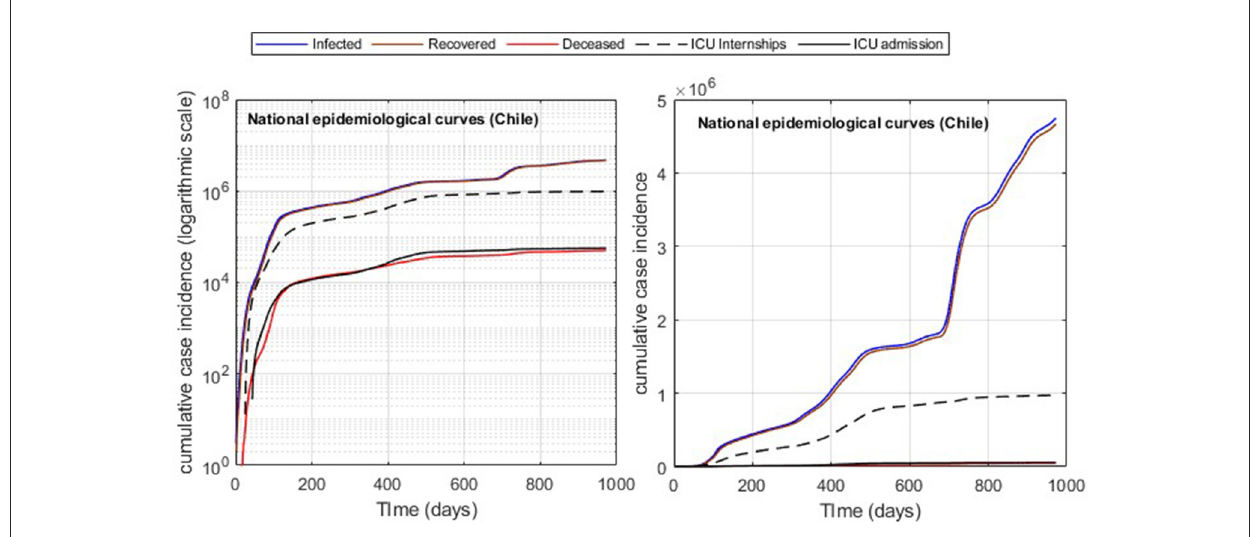
FIGURE3 Cumulative incidence curves (Chile). Logarithmic and raw data, respectively.